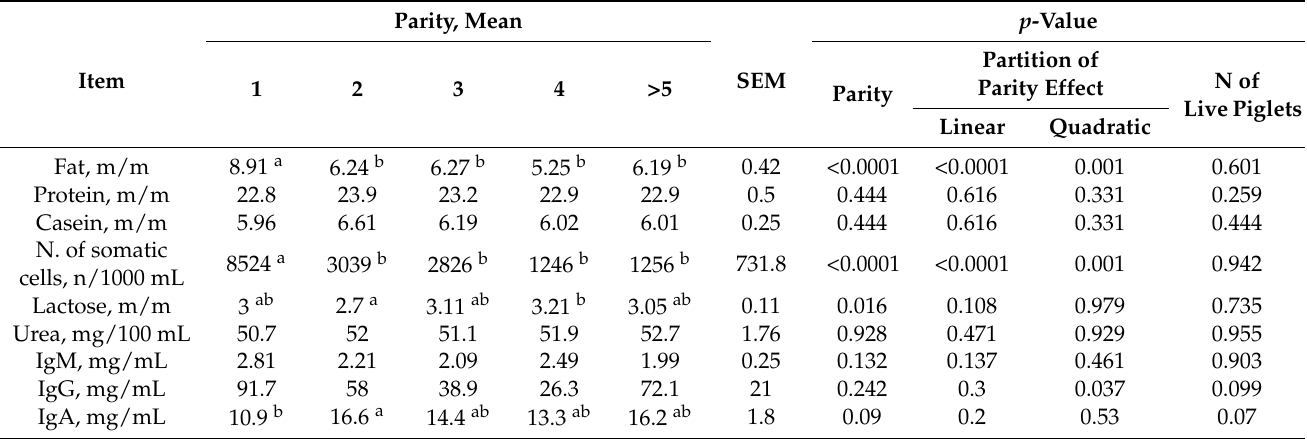
Table 4. Effect of sow parity on the colostrum composition, the number of somatic cells, and the immunoglobulins.